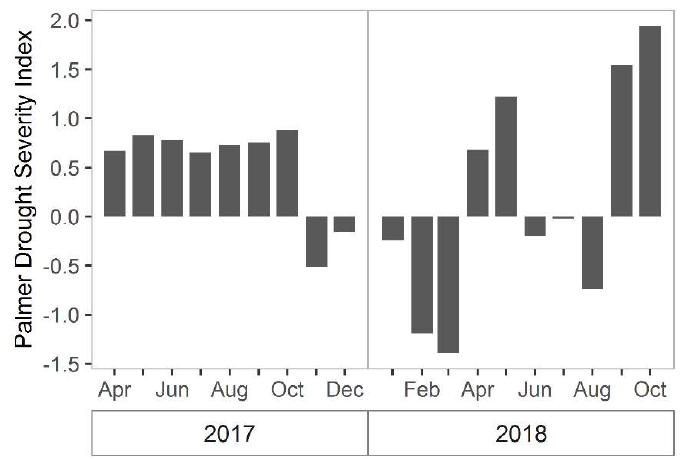
Figure 7. Palmer drought severity index for the Northeast South Carolina region. This region encompasses North Inlet. Negative values indicate drought and positive values indicate wet periods. Values between 0.5 and 1 indicate “inceptive wet periods,” values between 1 and 2 indicate slightly wet, values between −0.5 and −1 indicate incipit dry spells, and values between −1 and −2 indicate mild drought.